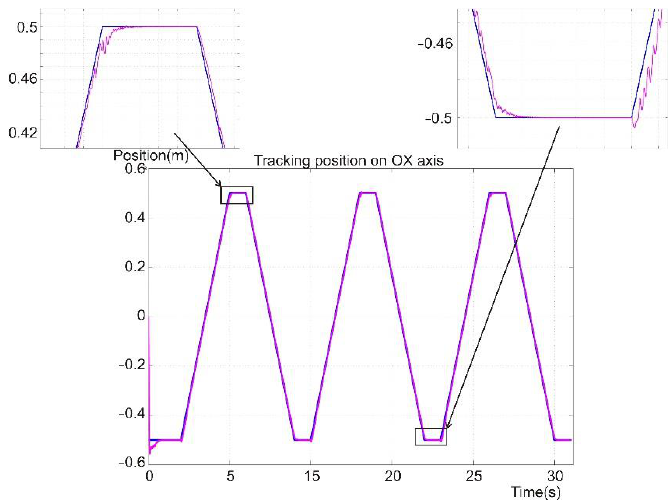
Figure 17. Foot reference and position tracking on the OX axis.